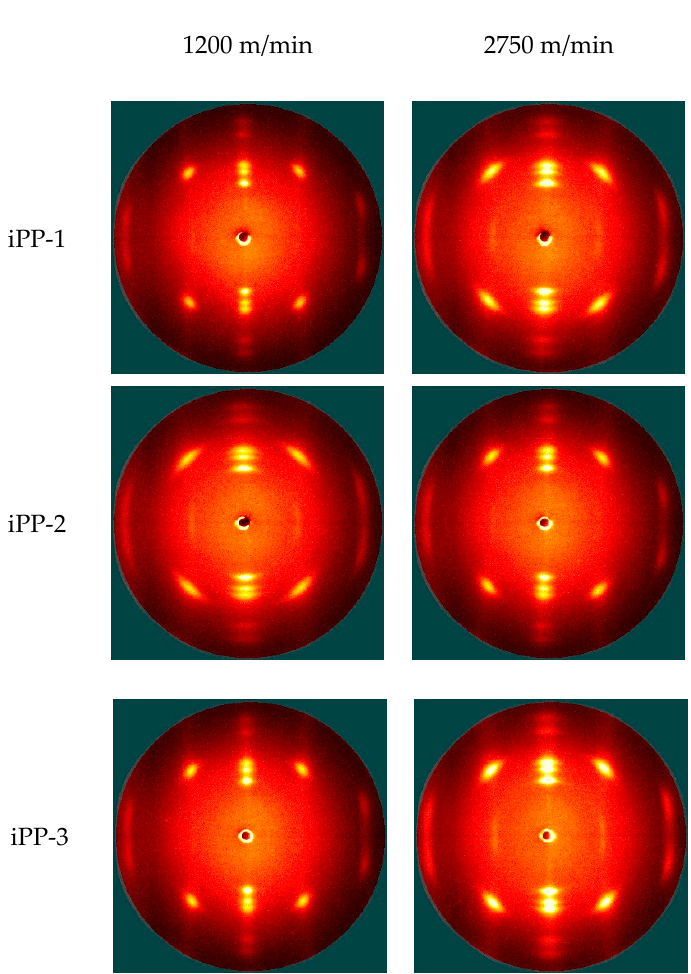
Figure 8. 2D WAXD patterns of drawn iPP fibers (draw ratio: 1.6).